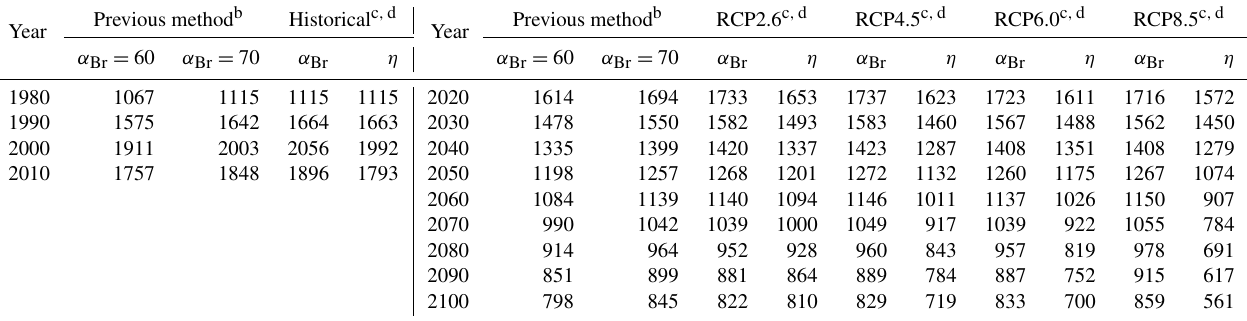
Table 3. EESC (pptv) and EESBnC (pptv) for historical and future chemistry–climate states a . Year